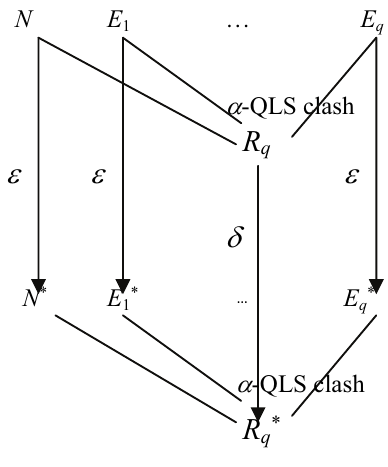
Fig. 1 Transformation